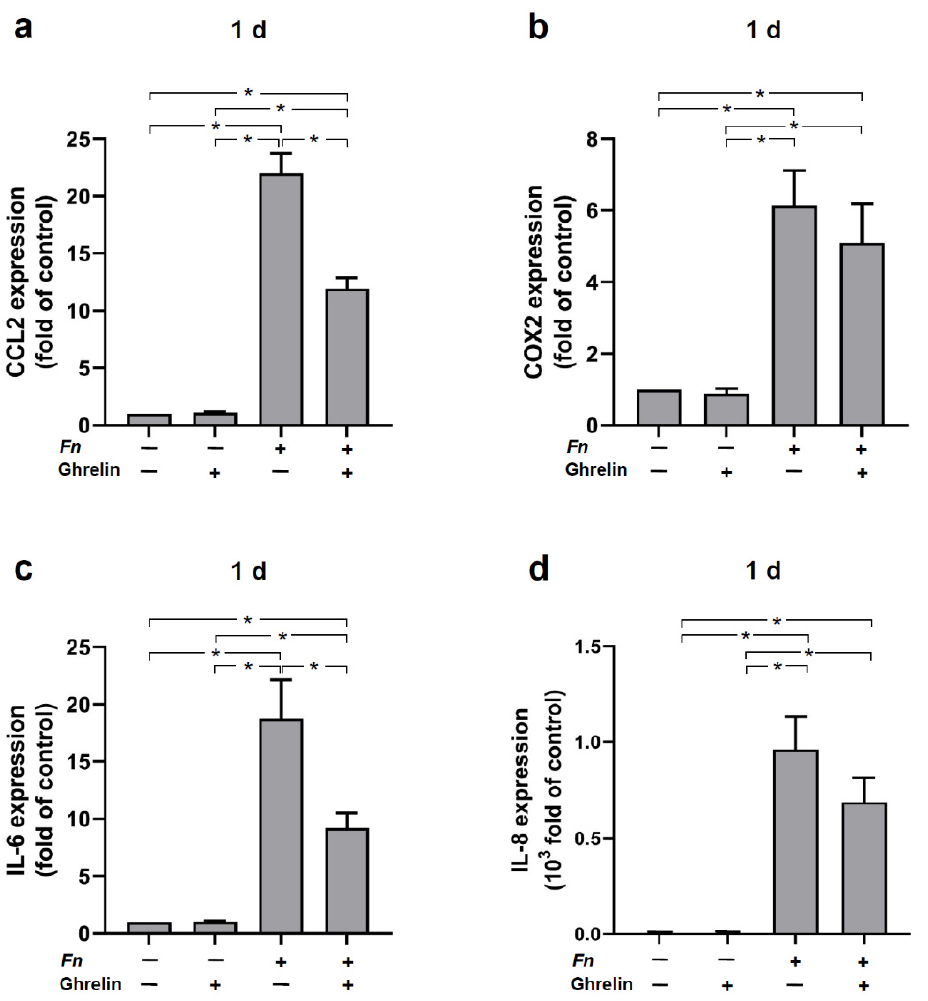
Figure 4. Expression of CCL2 ( a ), COX2 ( b ), IL-6 ( c ), and IL-8 ( d ) in the presence (+) and absence ( − ) of F. nucleatum ( Fn ATCC 25586, OD 660 : 0.1) and/or ghrelin (20 nM) in HGF cells at 1 d, as determined by real-time PCR. Mean ± SEM (n = 9). * Significant ( p < 0.05) difference between groups. Unstimulated cells served as control.